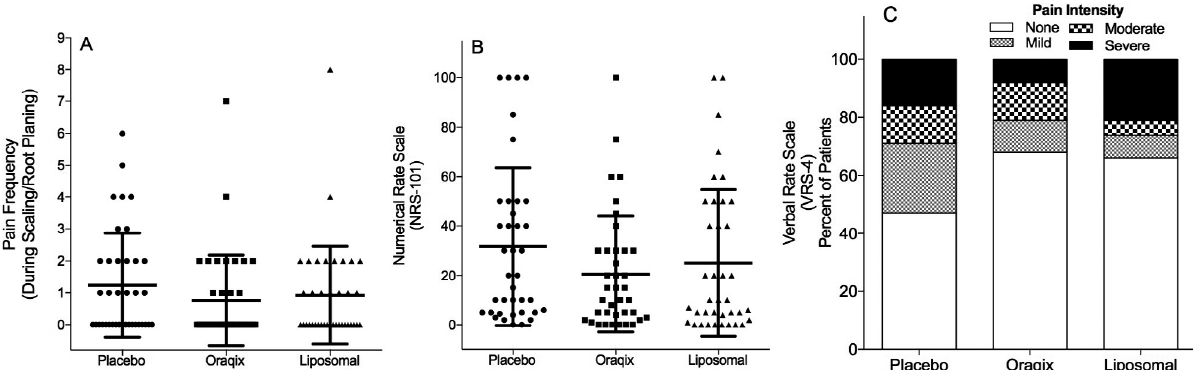
Figure 2- Pain during/after scaling and root planing in periodontal therapy. (A) Median with interquartile range (lines) of pain frequency (no significant findings, p=0.316). (B) Median with interquartile range (lines) of NRS-101 (no significant findings,p =0.250). The dots correspond to each volunteer. (C). VRS-4 scores: Percentage of subjects in the Placebo, Oraqix ® ; and Liposomal groups who reported no, mild, moderate, and severe pain (no significant findings, p=0.231). Kruskal-Wallis